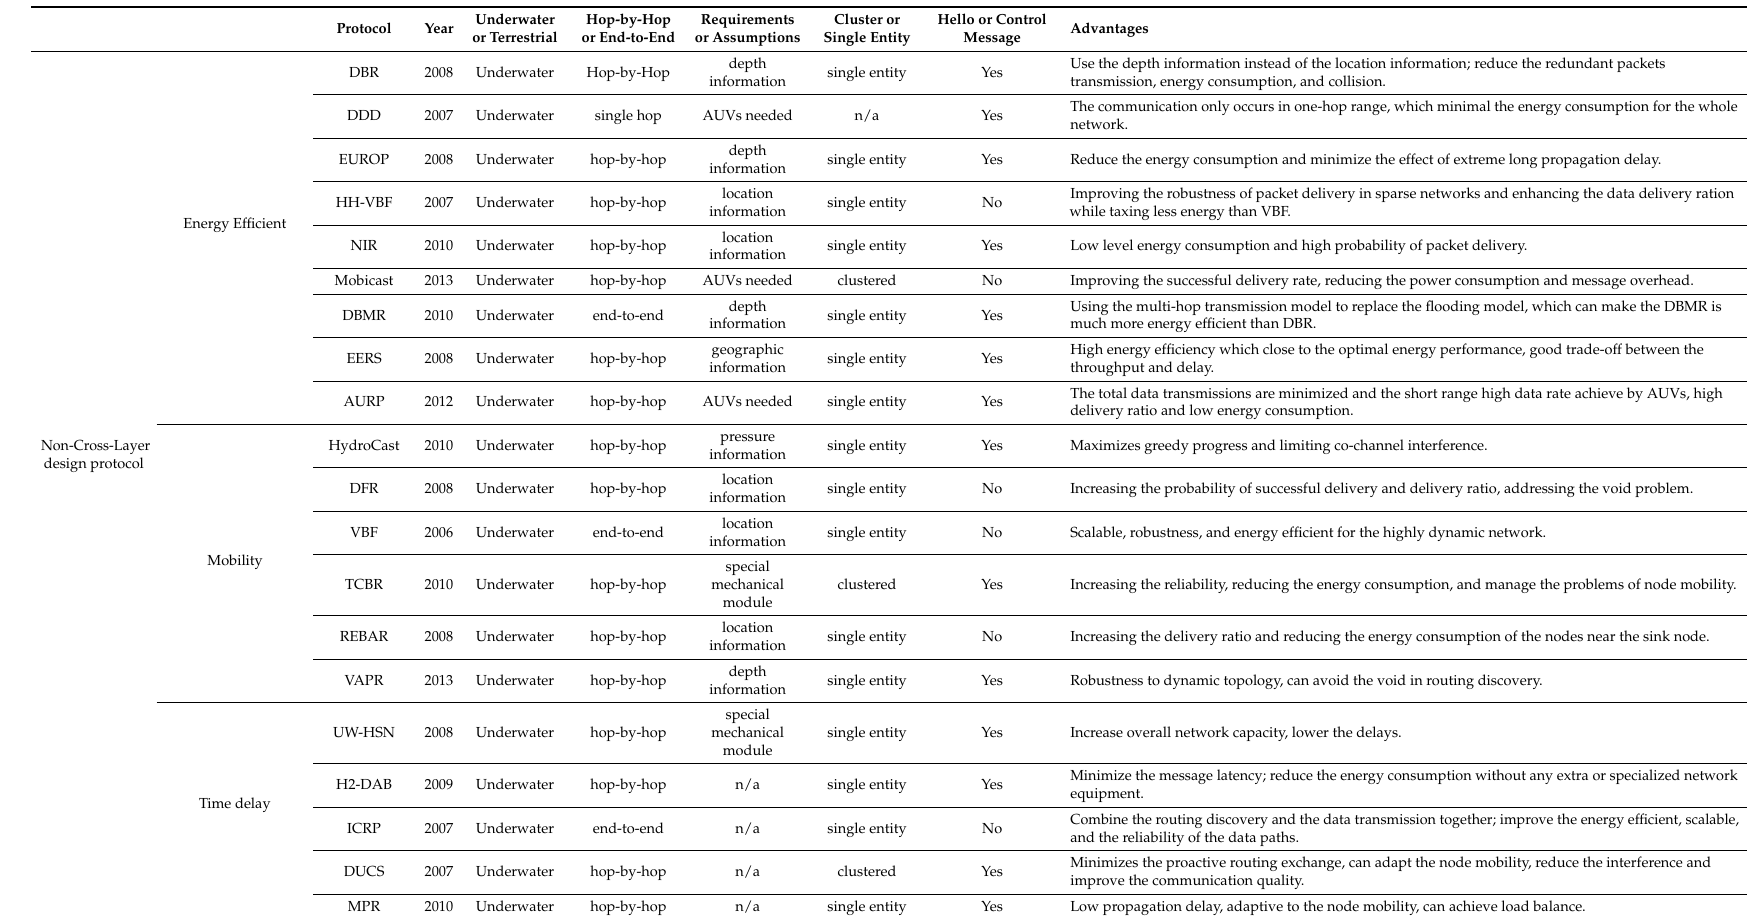
Table A1. The classification and the comparison of the UASN routing